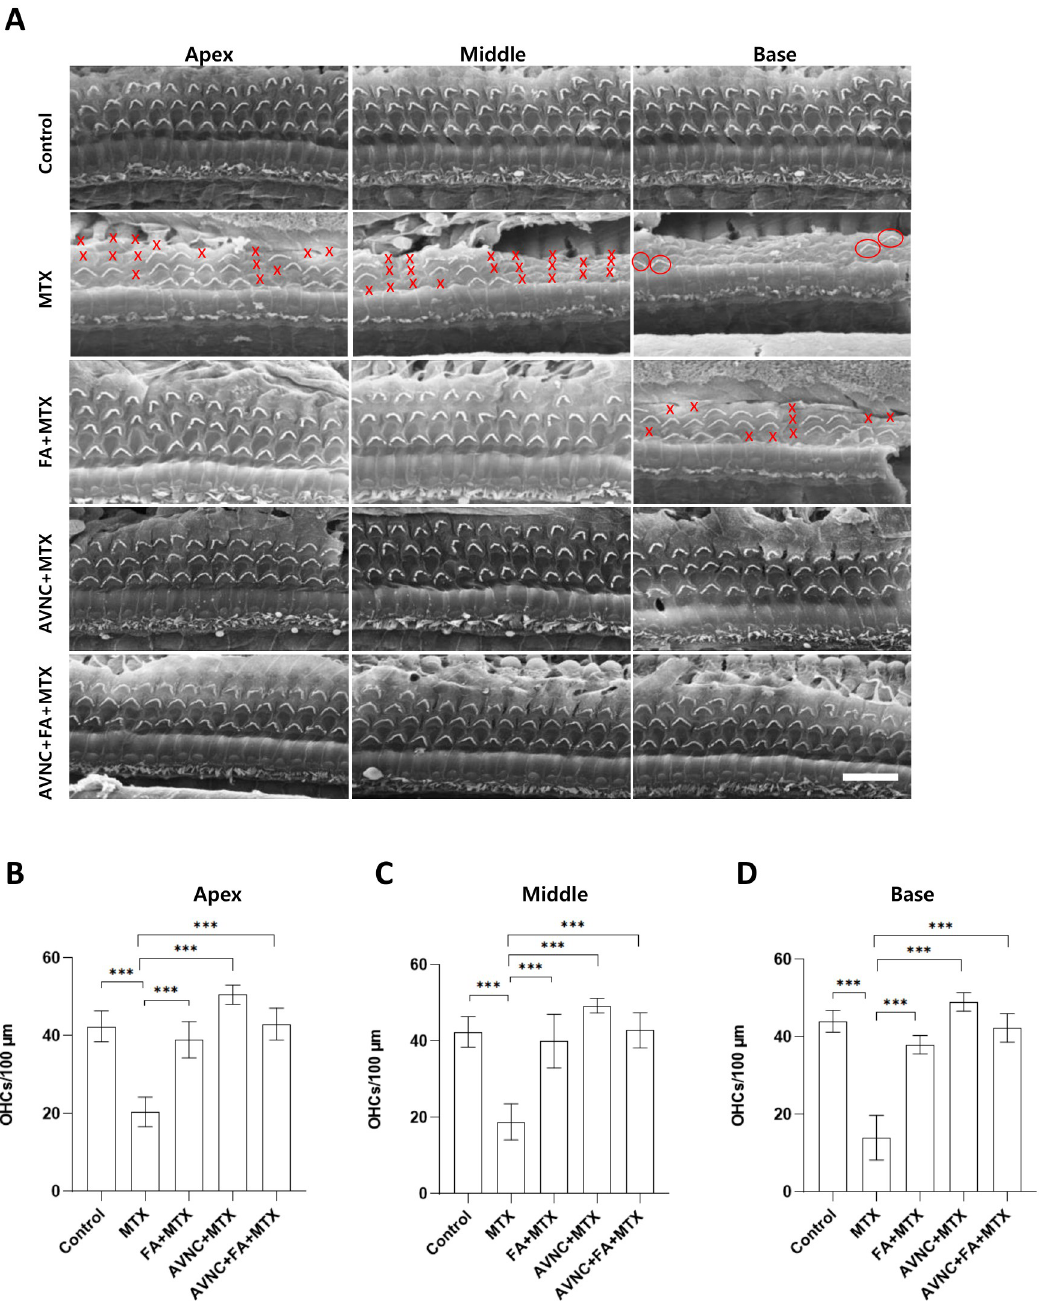
Fig 3. AVN-C and FA MTX defend OHCs from MTX-induced ototoxicity by ABR. A. In all cochlear turns, MTX severely damaged the OHCs. When administered 1 hour before MTX, AVN-C and FA shielded the OHCs against MTX-induced ototoxicity. B, C, and D. AVN-C treatment retained a greater number of OHCs at the cochlea turns than FA treatment. A, B, C, and D: ��� p < 0.001; one-way ANOVA. n = 7, and scale bar: 10 μ m. X represents loss of OHC and O indicates the presence of OHC in the figure (red